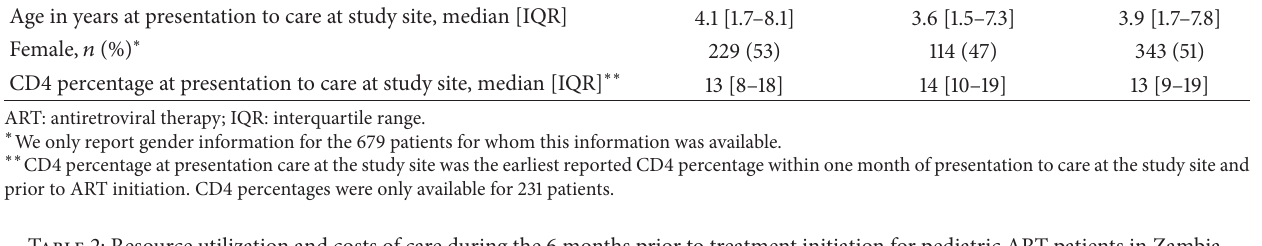
Table 2: Resource utilization and costs of care during the 6 months prior to treatment initiation for pediatric ART patients in Zambia.